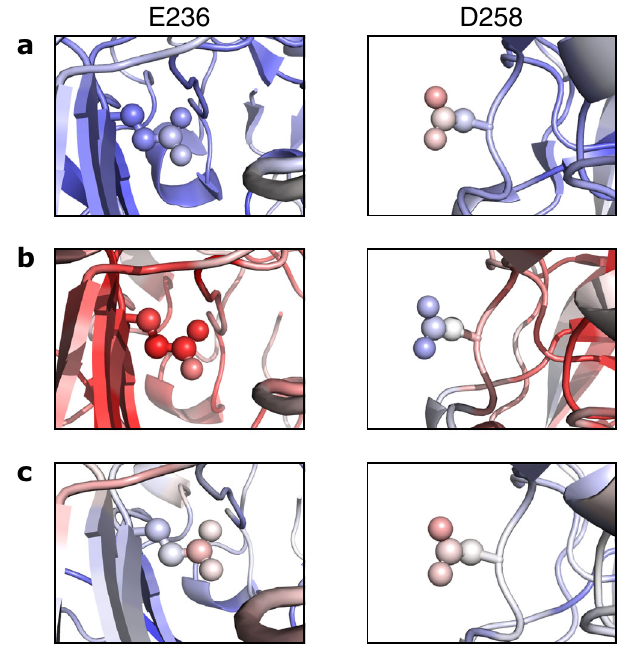
Fig. 1 Illustration of the B Damage metric. A damaged structure of GH7 family cellobiohydrolase (PDB accession code 5MCN 35 ) is coloured (blue: low value; red: high value) by a B -factor, b packing density and c B Damage . The side chains of E236 and D258 are shown (as spheres) in the left- and right-hand images, respectively; although they have different B -factor values because the local packing density environments of the two residues are different, their B Damage values reveal the two residues to be similarly damaged. An atom ’ s packing density is de fi ned as the number of non- hydrogen atoms within a 7 Å radius in the context of the crystalline structure. For visual clarity, only a single asymmetric unit copy is shown, however packing density and B Damage values have been calculated in the context of the crystalline structure as described in the Methods. Accordingly, the B net metric measures the skewness of the B Damage values of a structure ’ s aspartate and glutamate side-chain carboxyl group oxygen atoms (the B Damage -Asp/Glu distribution ) in relation to the B Damage values of all atoms in the structure. Speci fi cally, B net is calculated from the kernel density estimate of the B Damage -Asp/Glu distribution plus the median B Damage value of all atoms in the structure: it is de fi ned as the ratio of the area (B) under the curve on the right-hand side of the median to the area (A) under the curve on the left-hand side of the median (Eq. 1 and Fig. 2).